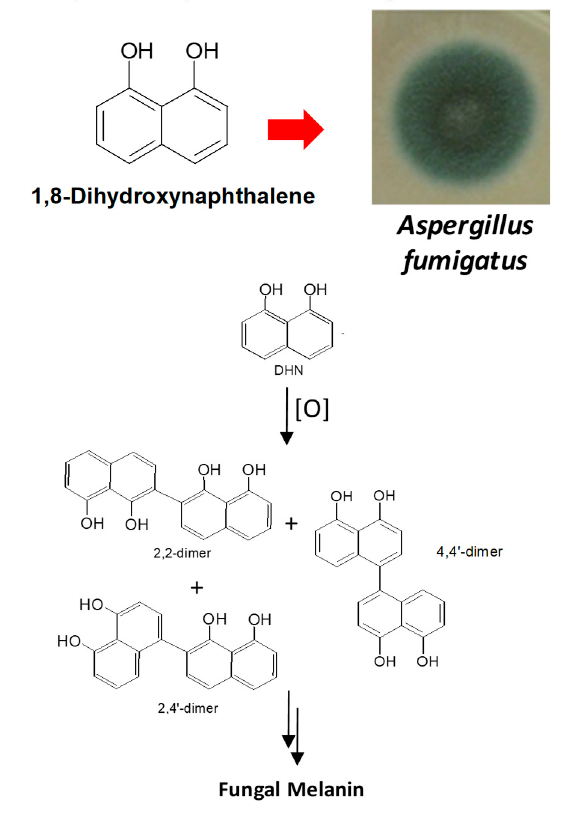
Figure 2. 1,8-Dihydroxynaphthalene as precursor of allomelanins in fungi.